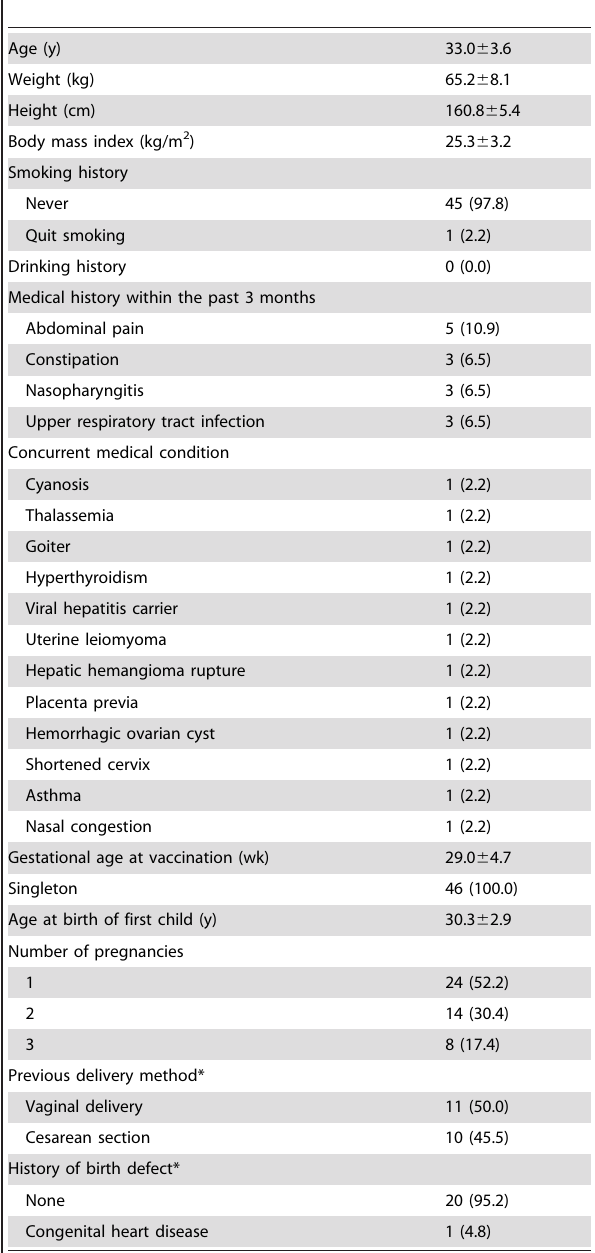
Table 1. Demographic, clinical, and obstetric characteristics of the 46 participants.